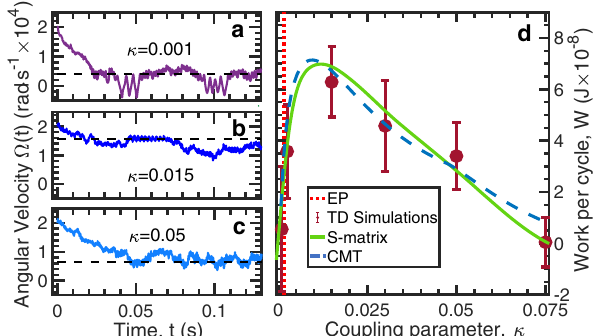
Fig. 3 Langevin dynamics and work. a – c The dynamics of the angular velocity Ω ( t ) for some representative values of the coupling coef fi cient κ , whose terminal velocity Ω TD determines the work delivered by the photonic s circuit. The black dashed lines indicate the associated theoretical values of the saturation velocity Ω s , see Eq. (16). d Work performed by the two- resonator circuit setup versus the coupling parameter κ . The numerical evaluation for the work from time-domain (TD) simulations (dots with error bars) is based on the mean value of the terminal angular velocity Ω TD , see s Eq. (16). The error bars indicate the range of values for the work per cycle due to fl uctuations of Ω ( t ) after saturation, see “ Methods ” . The TD simulations match nicely with the theoretical predictions for the work (green line), given by Eq. (5) in terms of the S-matrix. The blue dashed line reports the work predicted by the coupled-mode theory (CMT) modeling, see Eqs. (4) and (8) and “ Methods ” . The vertical red dotted line indicates the position of the exceptional point